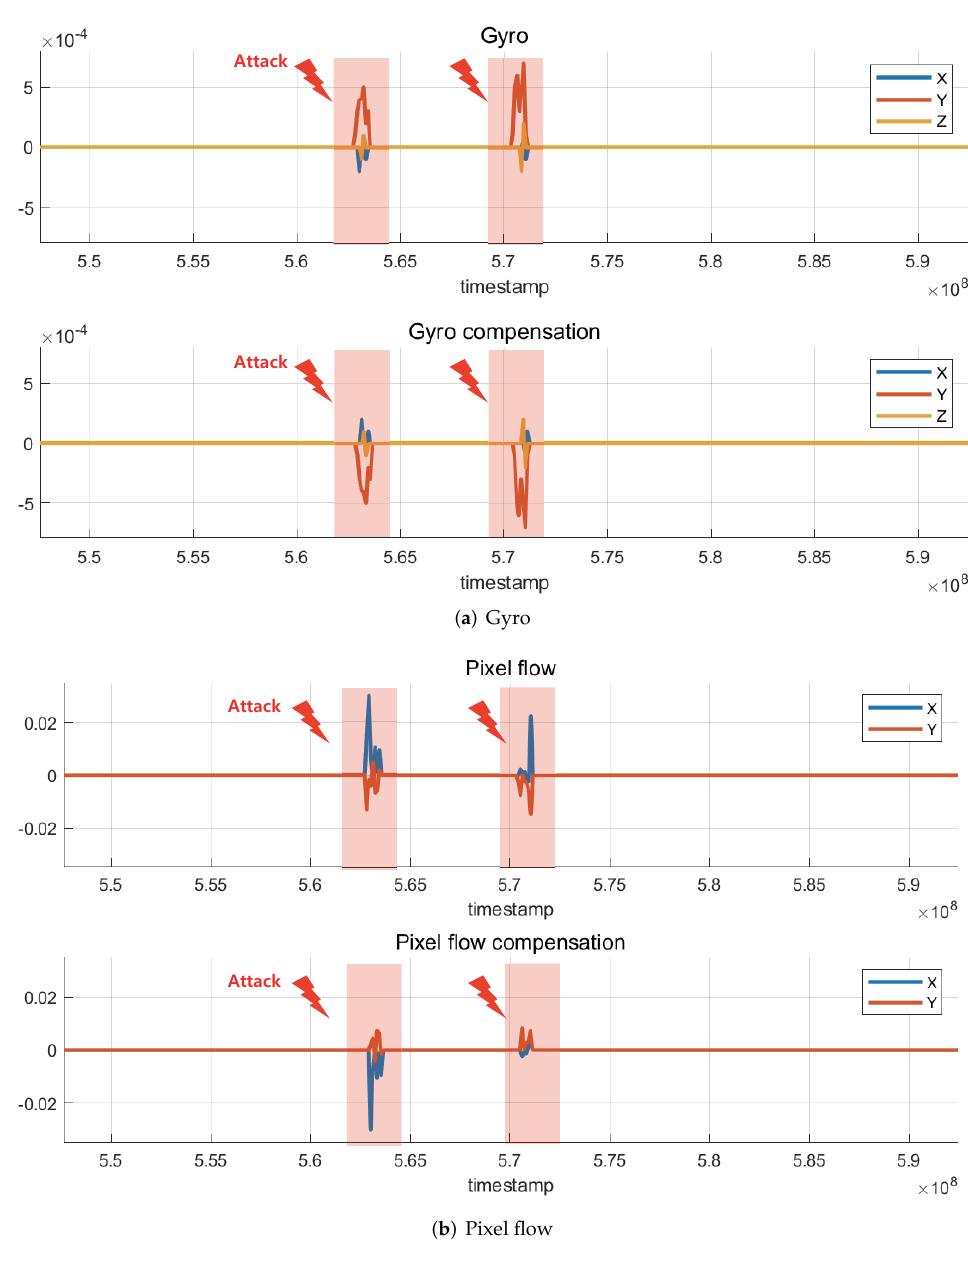
Figure 13. Monitored optical-flow sensor data. Abnormally calculated value led to the corresponding compensation value that might be critical for a stable flight. ( a ) When the attack was applied, the sensor calculated abnormal gyro data and the corresponding compensation value. ( b ) When the attack was applied, the sensor calculated abnormal pixel flow and the corresponding compensation